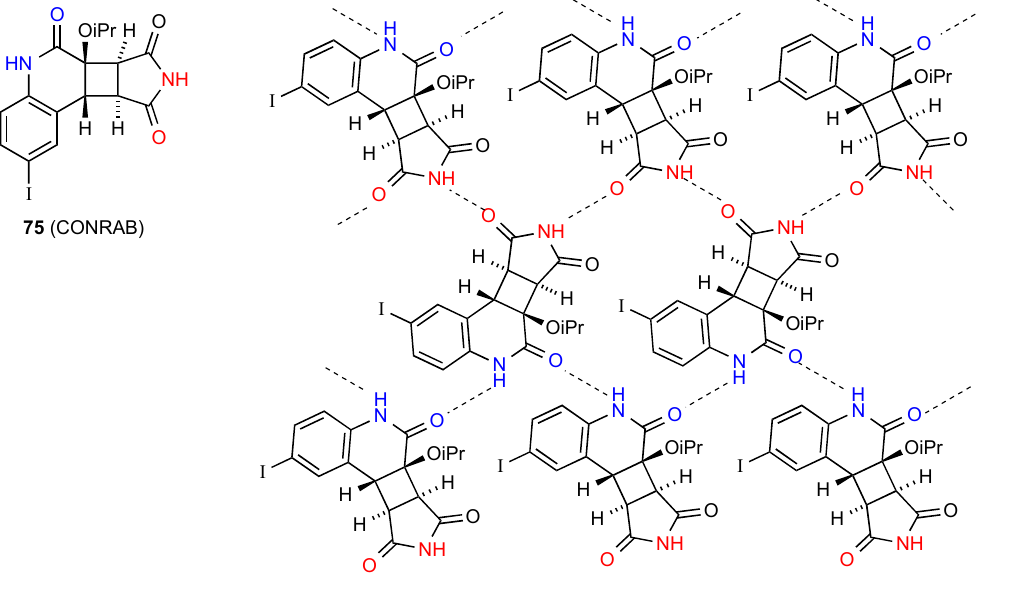
Figure 26. Structure adopted by compound 75.